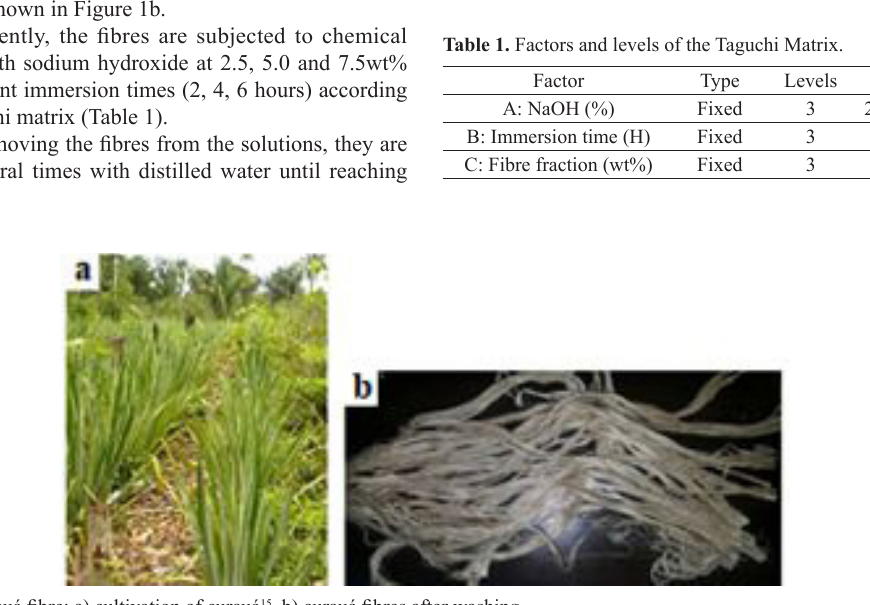
Figure 1. Curauá fibre: a) cultivation of curauá 15 , b) curauá fibres after washing.